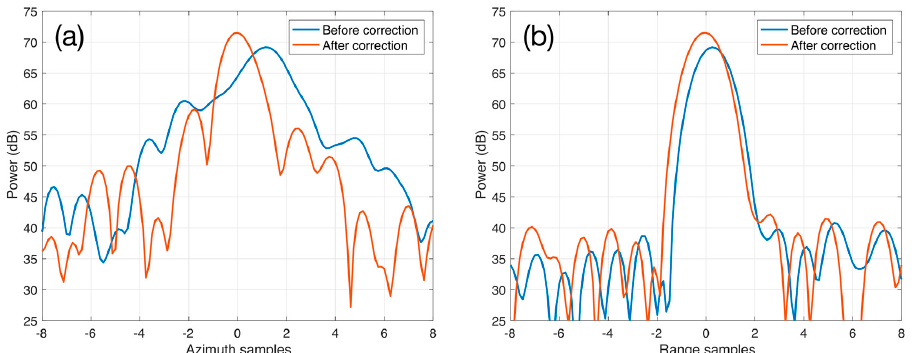
Figure 8. Power profiles crossing the center of the ground moving vehicle along the ( a ) azimuth and ( b ) range directions in Figure 7. Note the improvement in the peak sidelobe ratio by about 4 dB and that in the symmetry from 0.92 to 0.94 in the azimuth dimension, as in ( a ). In addition, the refocused object shifted by about 1.1 and 0.3 samples in azimuth and range direction, respectively.